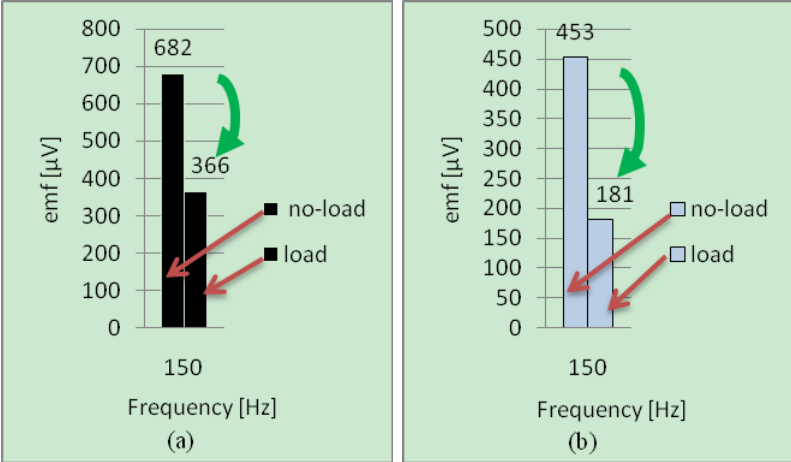
Figure 10. Harmonic components at 150 Hz for a healthy SSM at no-load and load operations for the two positions of measurement: (a) Position 2; (b) Position